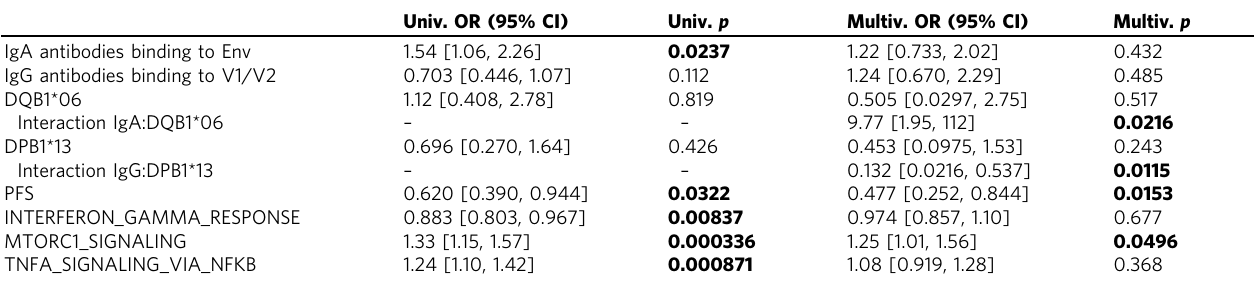
Table 1 Univariate and multivariate analysis of markers of HIV-1 acquisition among